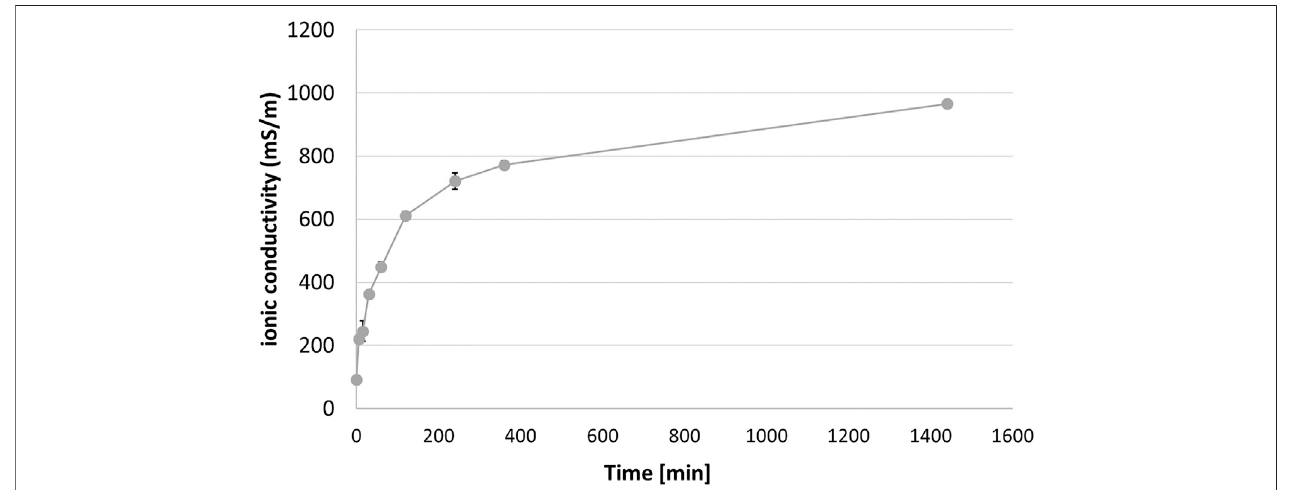
FIGURE 4 | Monitoring the ionic conductivity (mS/m) of water where a piece of sample GP-SW (S/L (cid:1) 1:10) was immersed at room temperature.